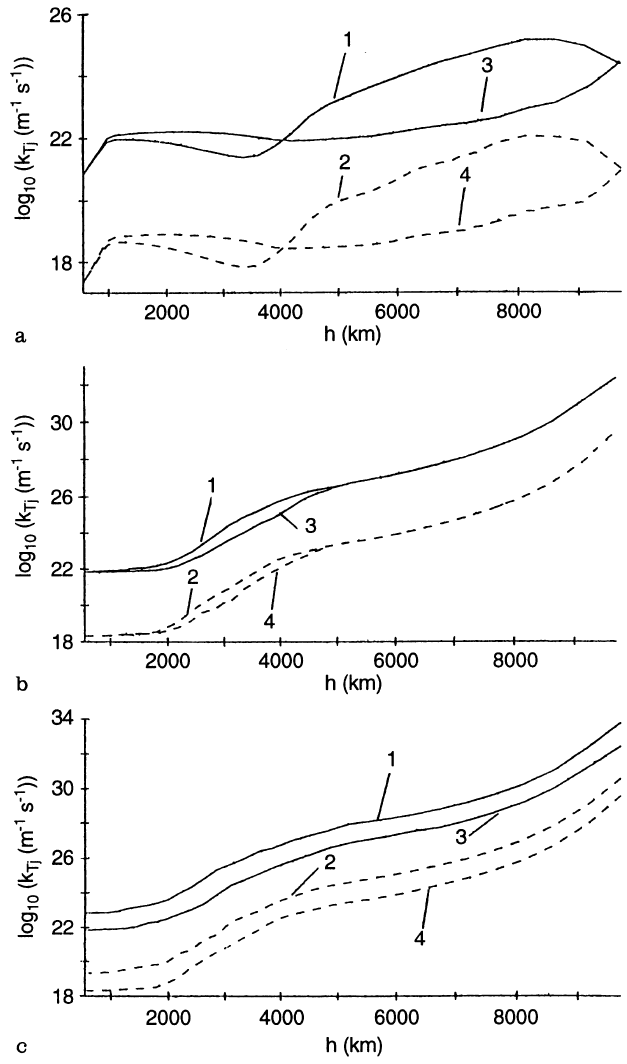
Fig. 3a–c. Coe(cid:129)cients of thermal conductivity k Tj of protons ( j (cid:136) 1, dashed curves ) and electrons ( j (cid:136) 2, solid curves ) versus altitude h . In